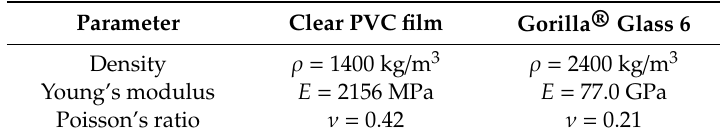
Figure 1. Phase velocities of A 0 Lamb wave mode in clear PVC films of different thicknesses d. Table 1. Parameters of clear PVC film and Corning ® Gorilla ® Glass 6.